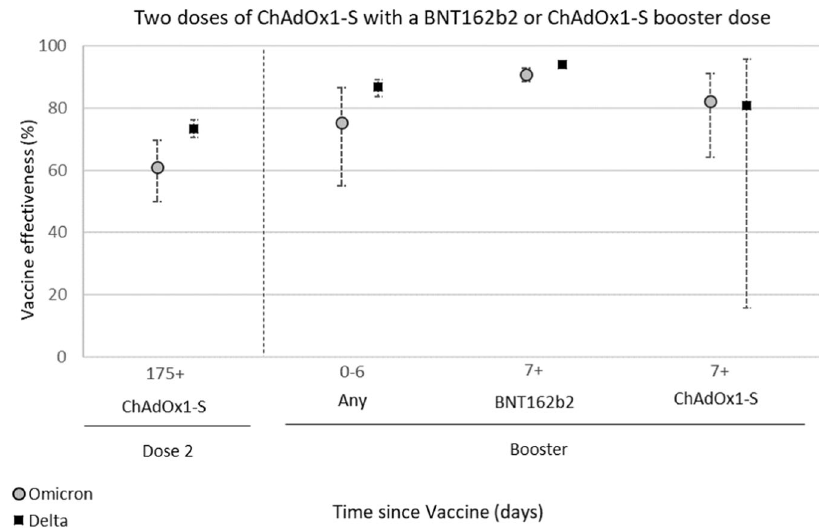
Fig. 1 | Vaccine effectiveness estimates with 95% con fi dence intervals of the ChAdOx1-S and BNT162b2 booster vaccines against hospitalisation as de fi ned by linkage to the secondary care (SUS) data following infection with Delta (black squares) or Omicron (grey circles) variants in adults aged 65 years and older in England. The ChAdOx1-S booster vaccine enhanced protection